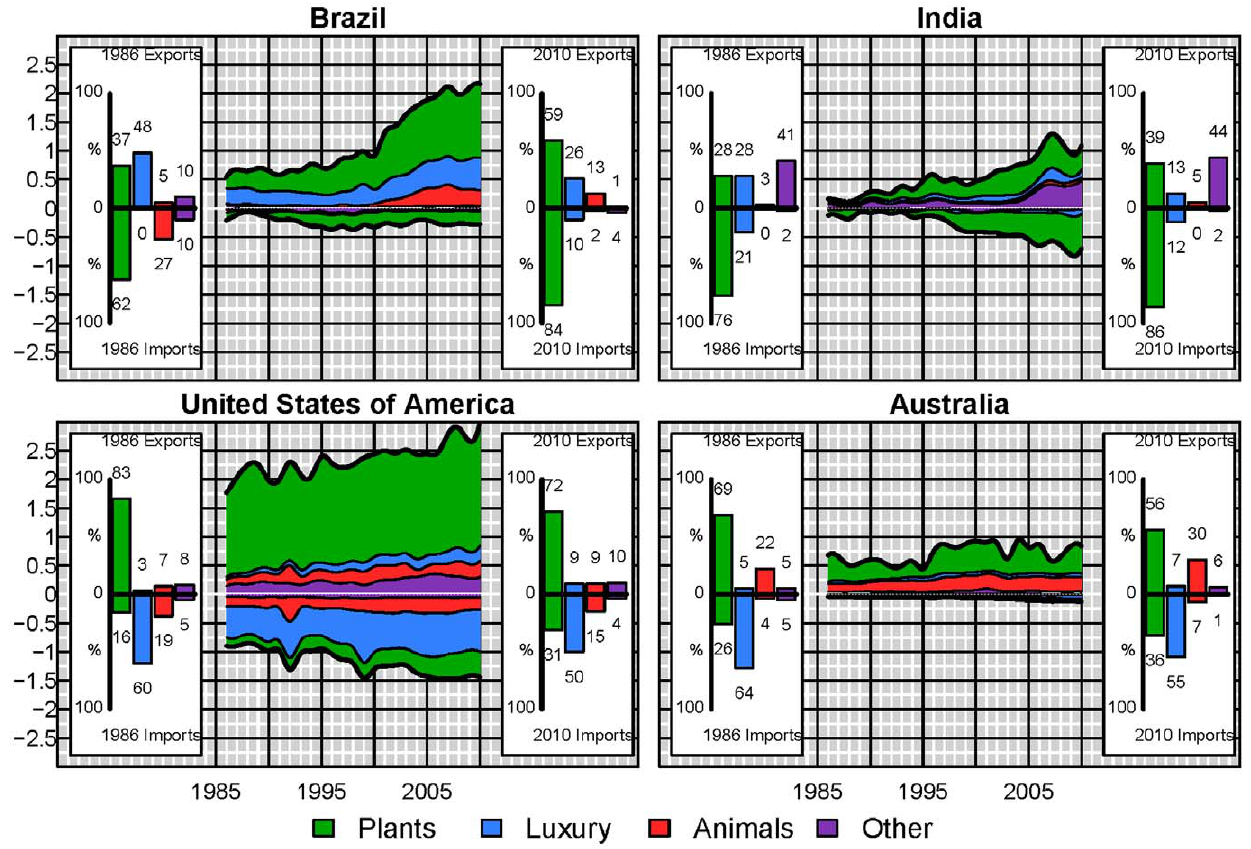
Figure 6. Detailed virtual water trade (10 11 m 3 ) by commodity type for Brazil, India, The United States of America and Australia. Positive values refer to exports and negative values to imports. The insets indicate the percentage of virtual water imports or exports contributed by plant, animal, luxury and other products.